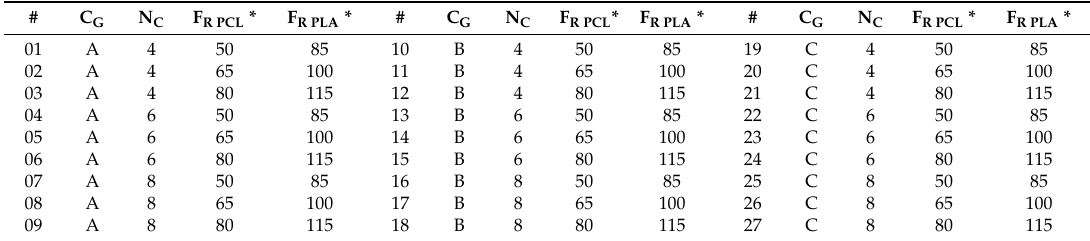
Table 1. Design of Experiments (DOE) of the 54 stents manufactured (27 PCL and 27